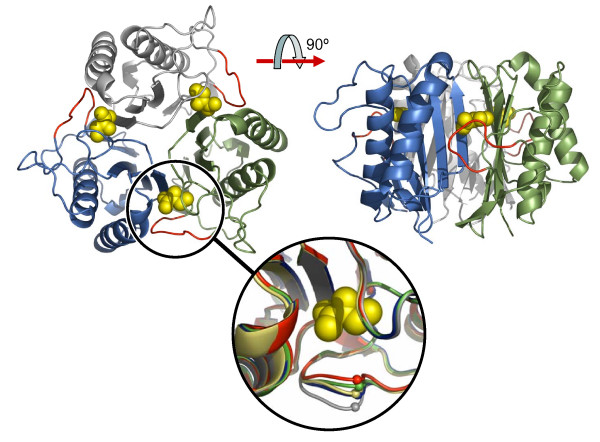
The overall structure of E. coli TdcF. Ribbon representation of the E. coli TdcF structure. Shown is the 2-ketobutyrate-bound form with the individual subunits coloured green, blue and grey; the 2-ketobutyrate ligands are shown in space-filling representation in yellow. Part of the loop between β1 and β2 that moves depending on the status of the ligand-binding pocket is shown in red for each subunit. The inset shows the extent of this movement in the various states, where: grey = empty site; blue = ethylene glycol-bound; yellow = serine-bound; green = propionate-bound; red = 2-ketobutyrate-bound. The small spheres indicate the variation in the position of the Cα atom of Ile-14, being the residue that is displaced the most (maximum displacement 4.2Å). It is notable that the loop is poorly ordered in the empty site and best resolved in the in the 2-ketobutyrate-bound site, where Ile-14 makes non-bonding interactions with the ligand. Figure generated using PyMOL [31].